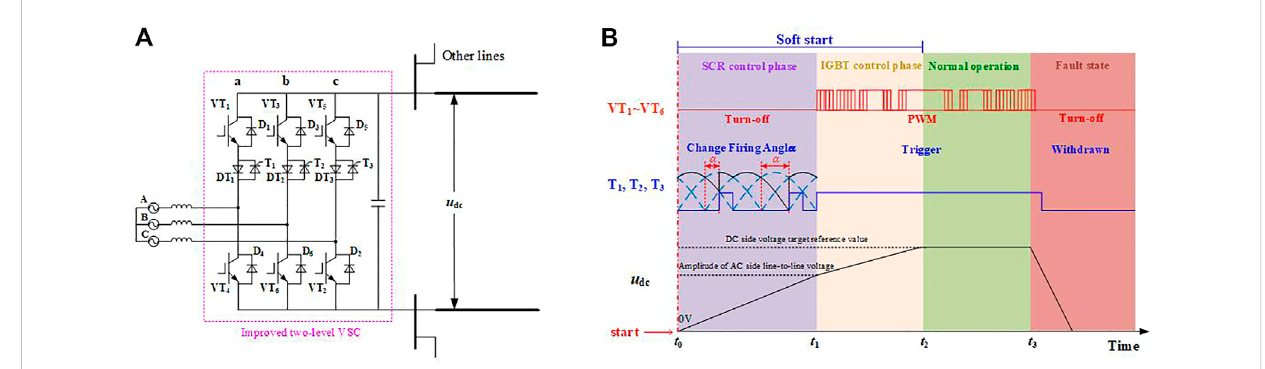
FIGURE 2 Topology and control sequence of the improved VSC. (A) Topology of the improved VSC; (B) control sequence for the improved